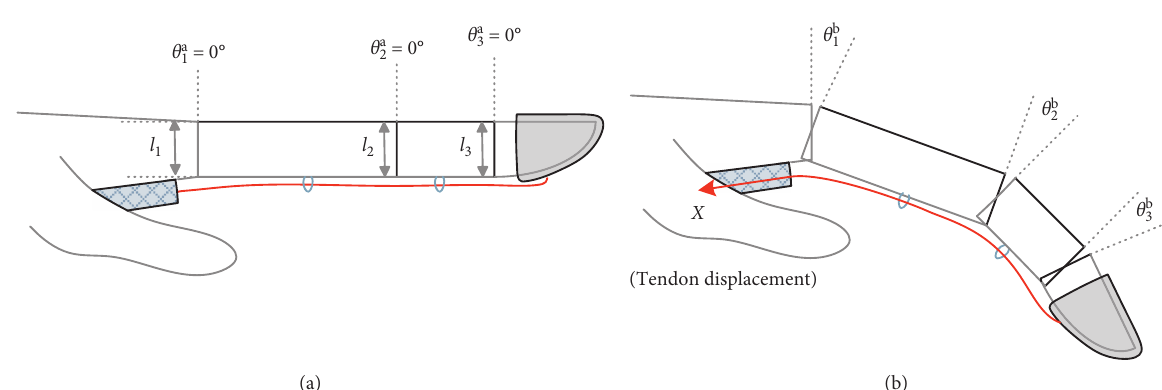
Figure 6: Relationship between tendon displacement and joint angle: (a) untensioned tendon and (b) tensioned